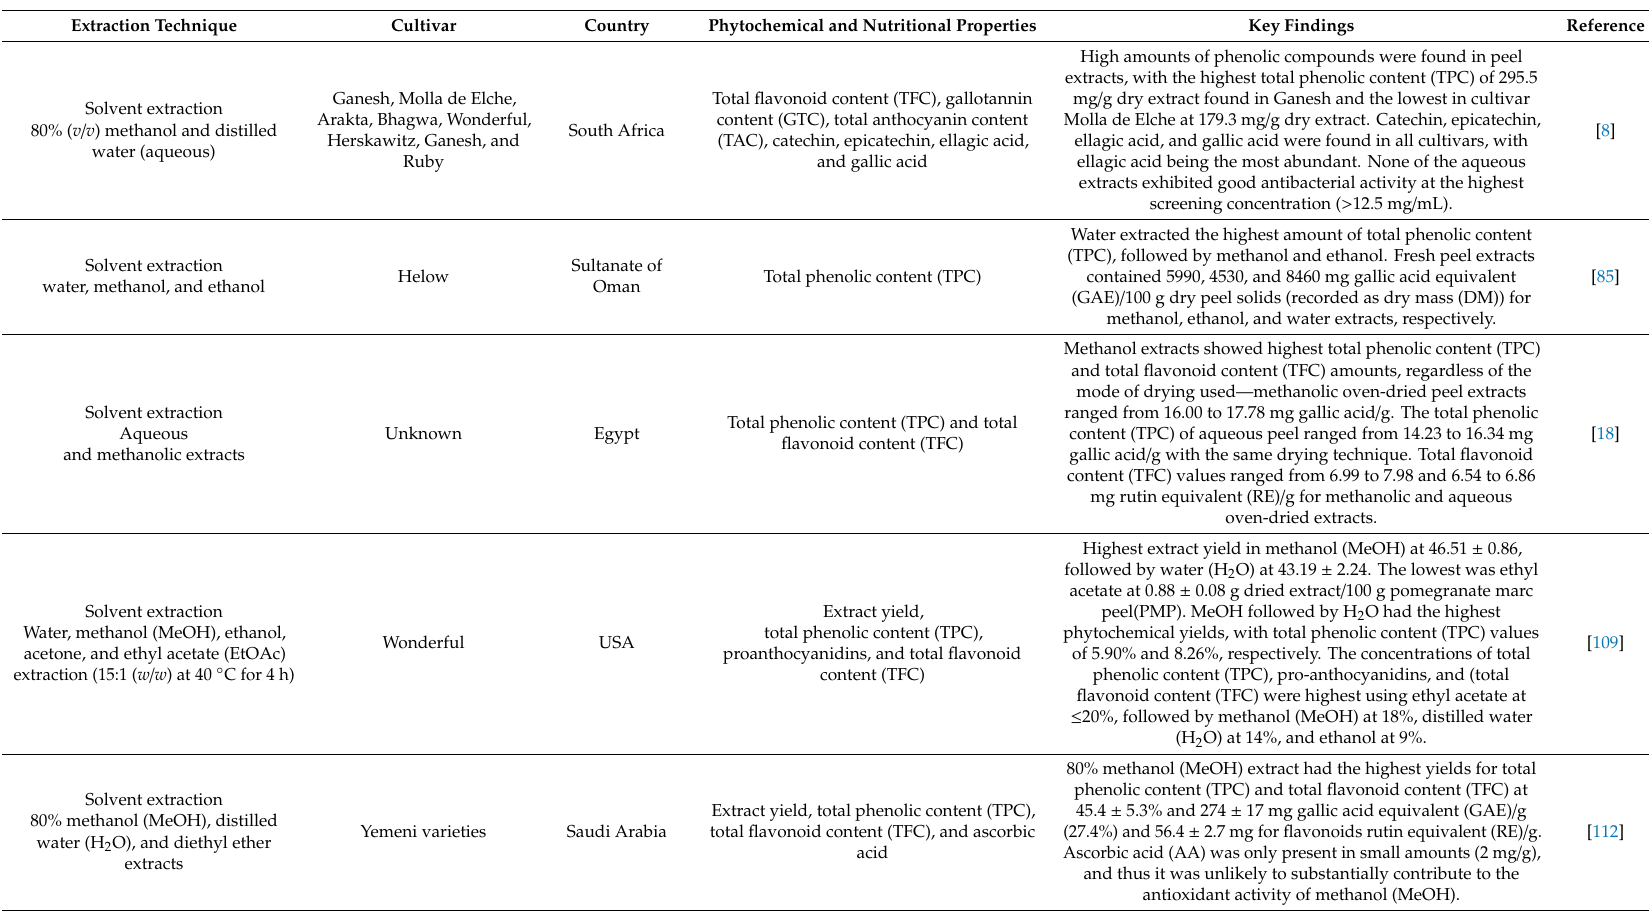
Table 5. The e ff ect of extraction techniques on the phytochemical and nutritional properties of the pomegranate peel